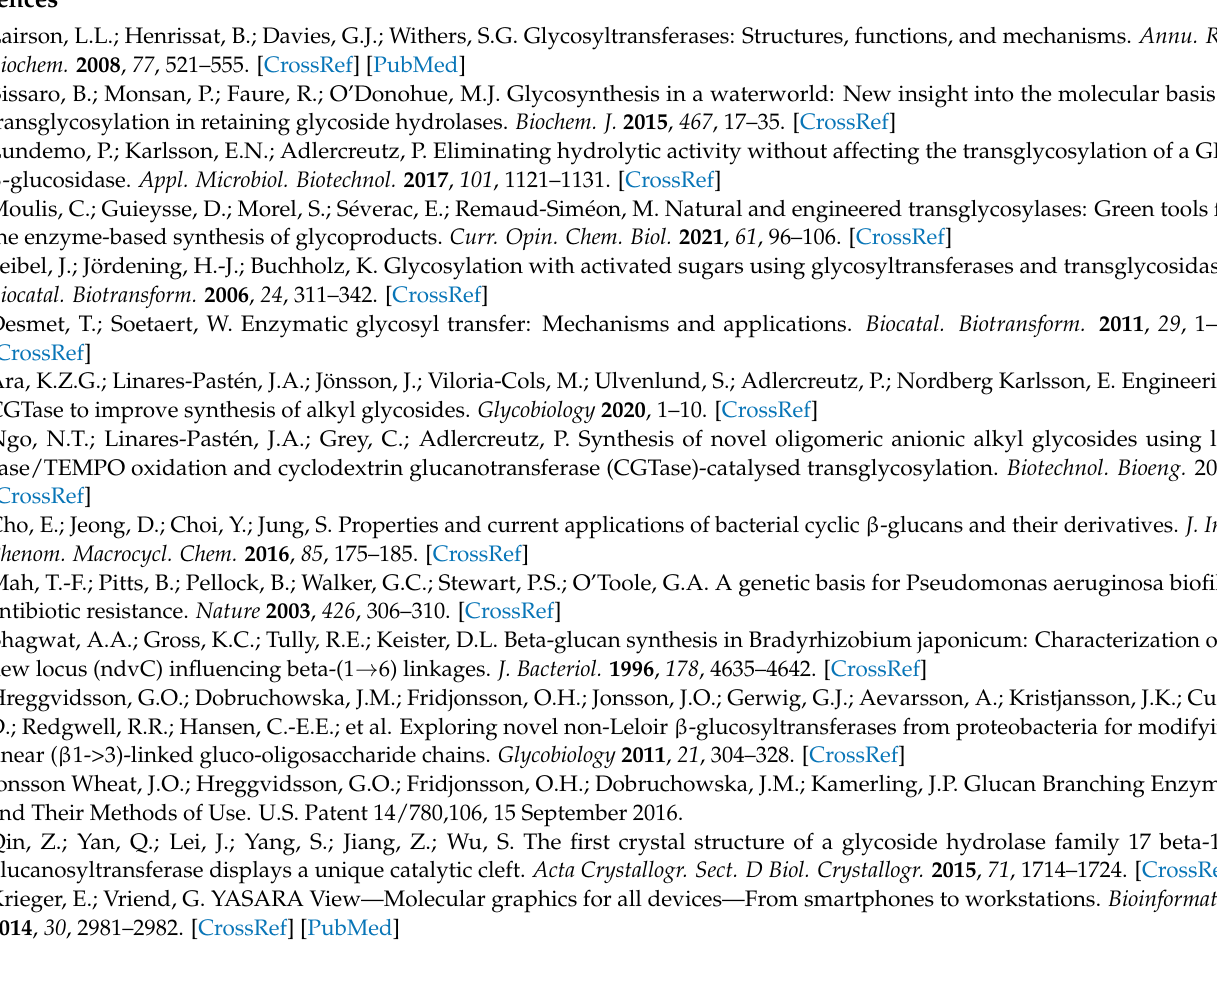
structure of Glts , Table S2: Contribution of fragments from other models to the hybrid models, Table S3: Mutagenic primers, Figure S1: Activity analysis of the wt MalE- Glt20 and the two single mutants of MalE- Glt20:E120Q and E209Q